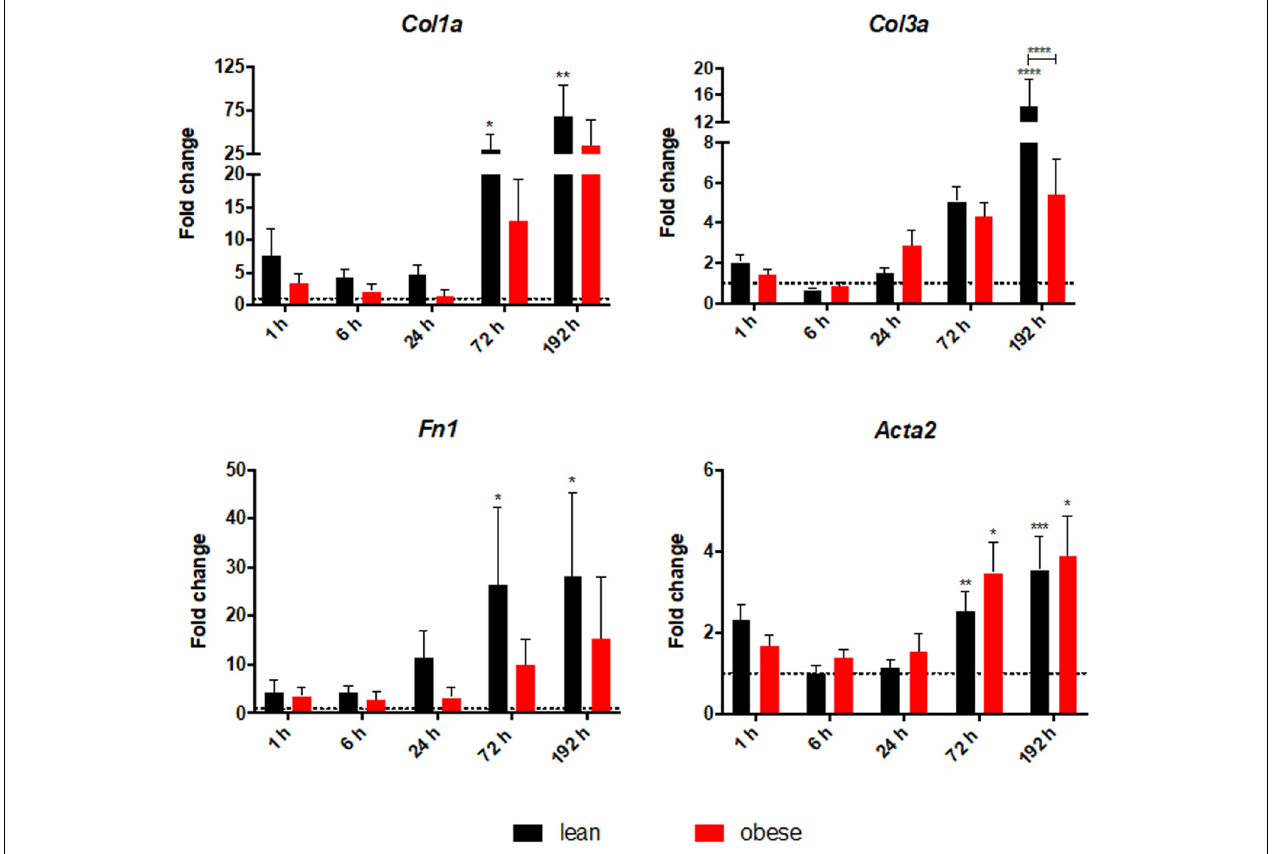
FIGURE 6 | Altered level of ECM structure genes in obese mice. Gene expression profile of ECM structure genes Col1a , Col3a, and Fn1 as well as Acta2 were determined in injured muscle of lean and obese trauma and control animals. Statistical significance was determined using two-way ANOVA followed by an uncorrected Fisher’s LSD test ( α = 0.05). * p < 0.05, ** p < 0.01, *** p < 0.001, **** p < 0.0001. Indicators of significance directly above the bars of the diagram indicate a statistical difference to the control, while starts above the connector line show differences between the two diets at that specific time